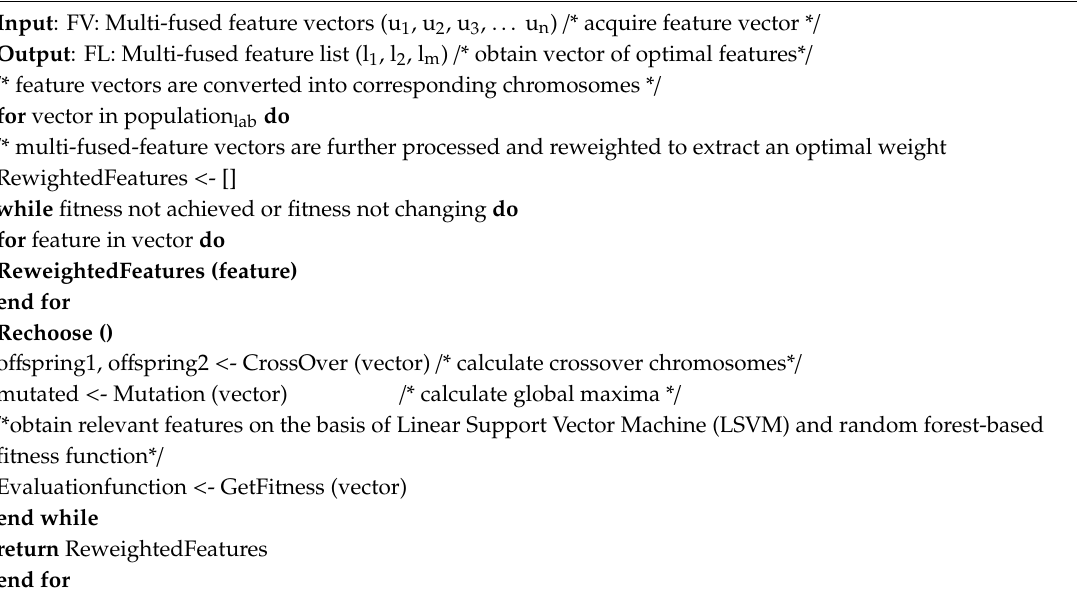
Algorithm 2: Genetic algorithm-based reweighted feature